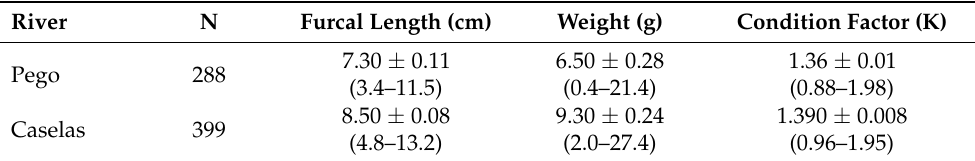
Table 4. Average ± standard error (range) of the furcal length, weight, and condition factor of the individuals of G. lozanoi in the two analyzed